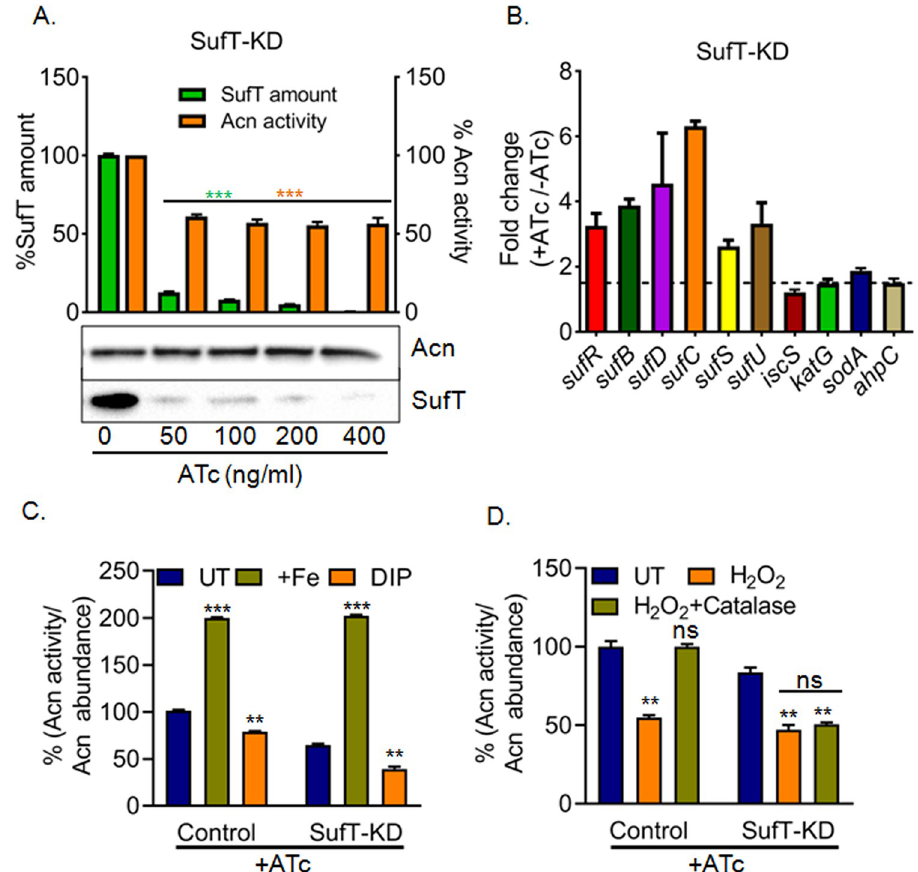
Fig 4. SufT participates in Fe-S cluster biogenesis and repair. (A) Western blot quantification of reduced SufT protein level (green bars) and decreased aconitase (Acn) activity (brown bars) was shown in SufT-KD strain, with increasing concentration (ng/mL) of ATc (0, 50, 100, 200 and 400). Level of SufT and enzymatic activity of Acn are normalized to Acn abundance from western blot. B) RT-qPCR based expression level of the suf operon ( sufR , sufB , sufD , sufC , sufS , sufU ), iscS , and anti-oxidant machinery ( katG , sodA and ahpC ) in SufT-KD strain. Horizontal dotted line indicates expression level below 1.5-fold considered as basal level. Data are shown as mean ± SD from triplicate reaction. (C) Acn activity was measured from cell free lysates derived from control and SufT-KD strains exposed to ATc (200 ng/mL) for 72 h and subjected to Fe-S reconstituted (Fe 2+ ) and Dipyridyl (DIP) treatment. UT; untreated. D) Acn activity of UT, H 2 O 2 and H 2 O 2 +Catalase treated cell lysates from control and SufT-KD strains were measured after 48 h of ATc (200 ng/mL) treatment. Student’s t test (two tailed) was performed here with p values, � p = 0.05, �� p = 0.01 and ��� p =